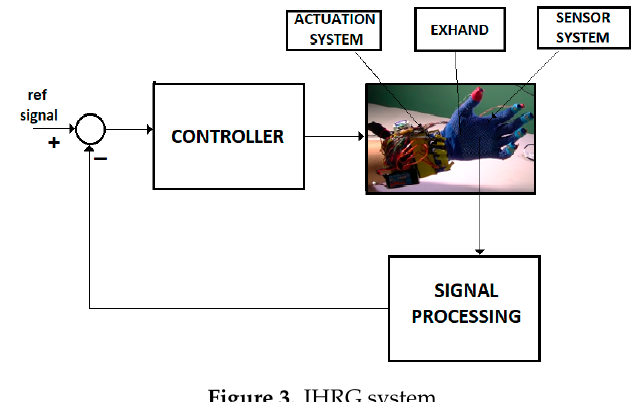
Figure 4. Control system.